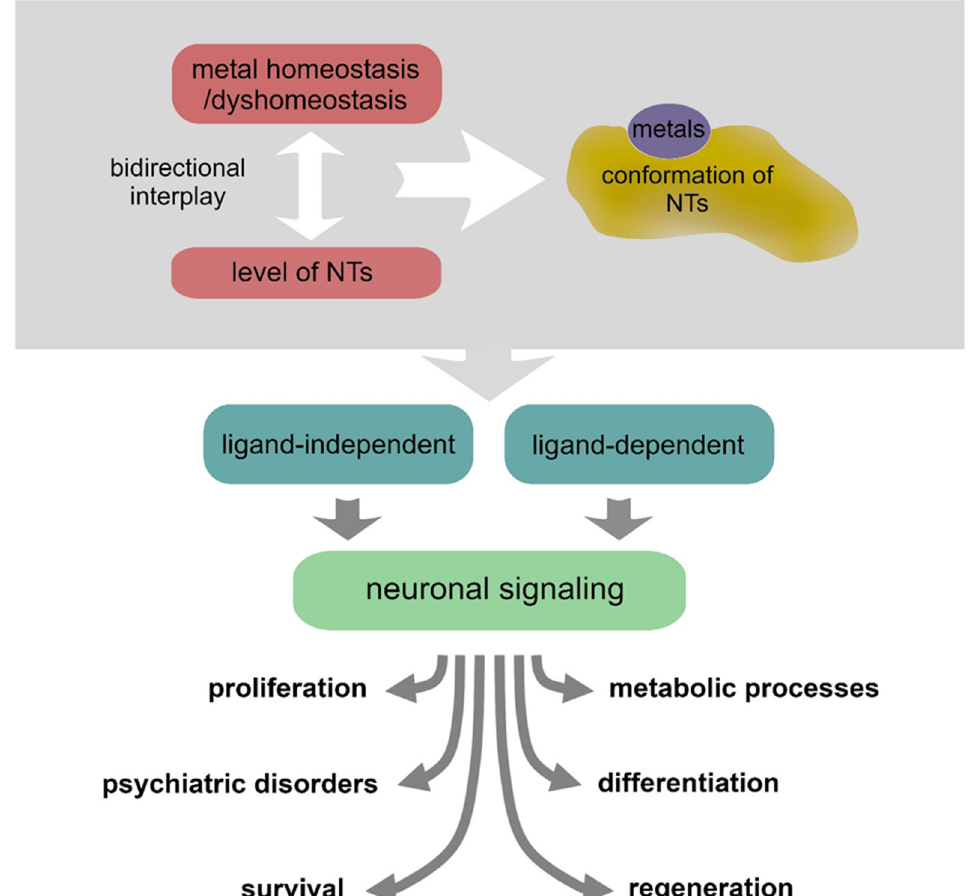
Figure 2. Metal homeostasis/dyshomeostasis can affect the expression, conformation and signaling of various neurotrophins, thus producing various effects on neuronal pathophysiology.